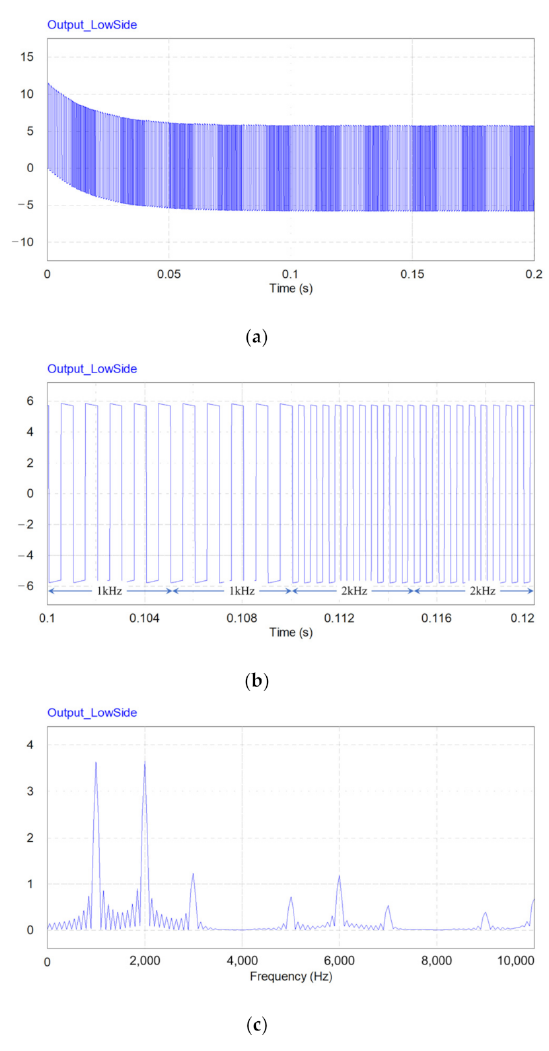
Figure 8. Frequency characteristics of the low side of the transmitter: ( a ) low side output; ( b ) Low side frequency; ( c ) low side